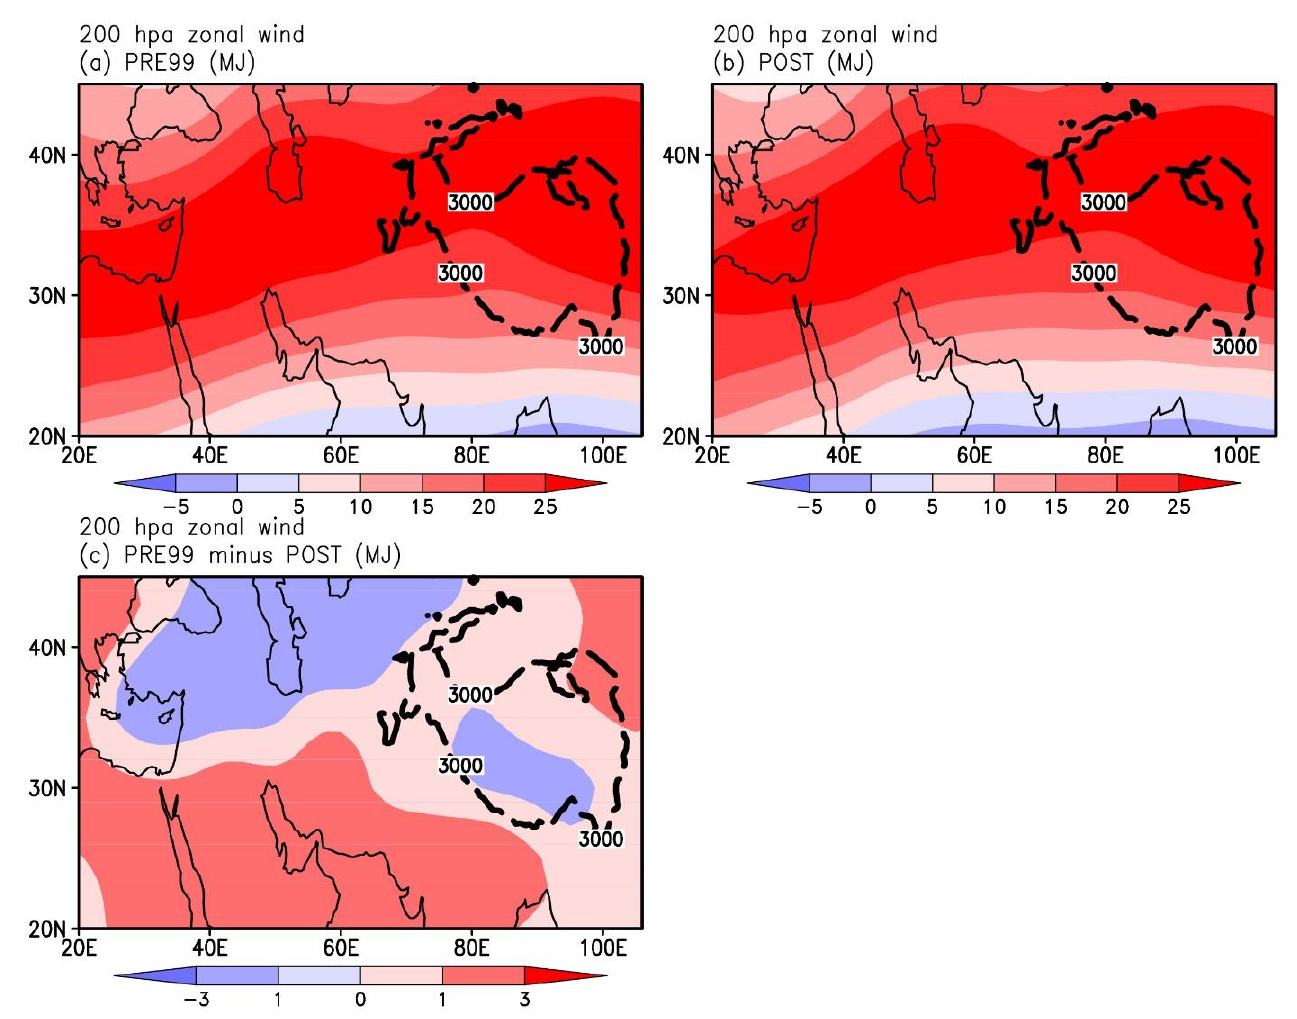
Figure 7. MJ zonal wind at 200 hPa (in m/s) ( a ) PRE99, ( b ) POST99, and ( c ) the difference between the two (i.e., MJ PRE99 − POST99). The 3000 m topographic isoline is shown by the dashed contour. To strengthen the claim made, the direct relationship of the upper TT variation to LWF and SWF is investigated. The association is quantified using a recently created “composite causality analysis”. The causal patterns generated by various time window sizes, such as 41, 51, 61, and 71 days, were applied; however, the resulting causal patterns are similar. For more details on “composite causality analysis”, please refer to [20]. The results